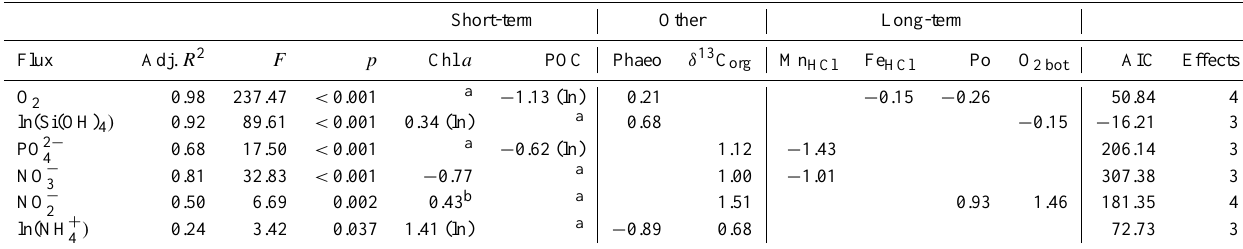
a Indicates that this short-term parameter was strongly correlated ( R = 0.92) to the (other) short-term parameter retained in the model. b Indicates that the factor was retained, but not significant in the